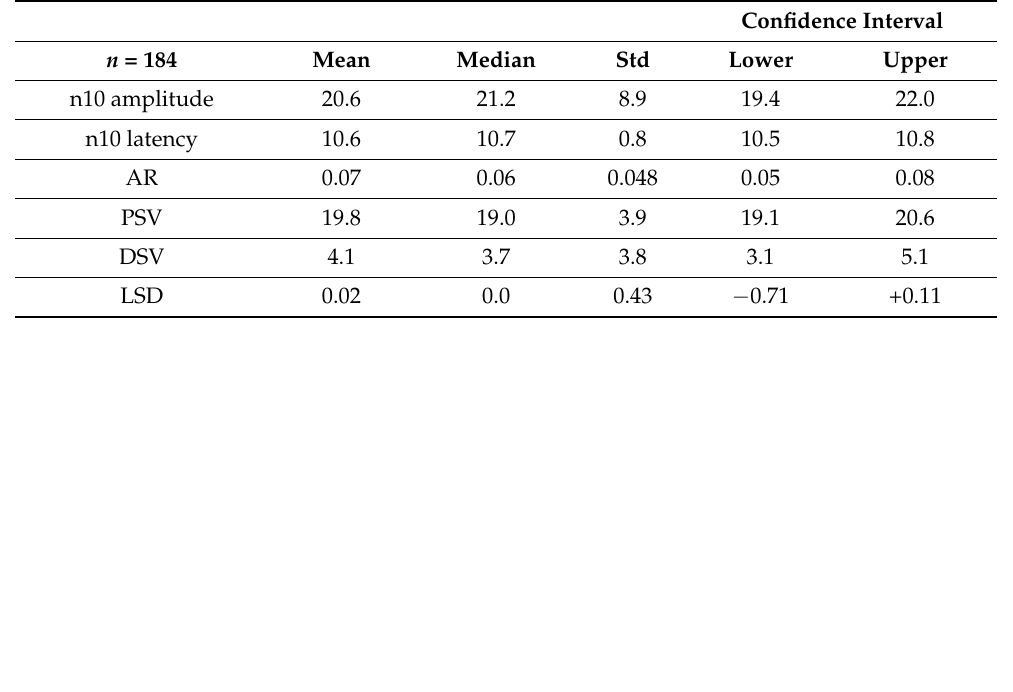
Figure 4. Normative data of n10 amplitude latencies from 92 volunteers: ( a ) the response of the left side (right measured); ( b ) the response of the right side (left measured); ( c ) the response from the left and right sides; and ( d ) the (latency shift difference (LSD): right side—left side). Table 2. Normative data (mean, median, and standard deviation (std)) with a confidence interval of 92 volunteers divided into 184 measurements of n10 amplitude, n10 latency, and asymmetric ratio (AR) with novel parameters of phase synchronization vector (PSV), delta shift-vector (DSV), and latency shift difference